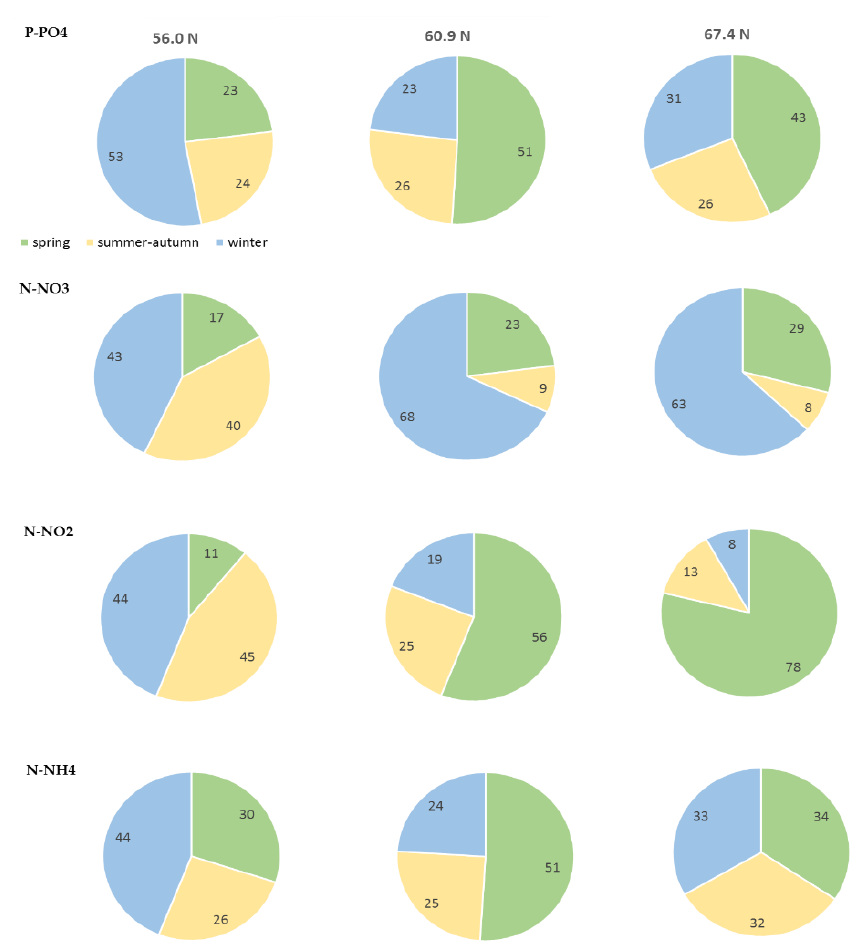
Figure 3. Relative seasonal distribution (%) of annual nutrient loads at different sections of the Yenisei river.